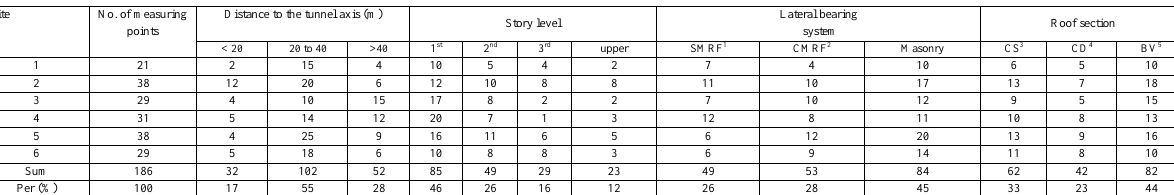
Table 2: Measuring point’s details. Site No. of measuring Distance to the tunnel axis (m) points